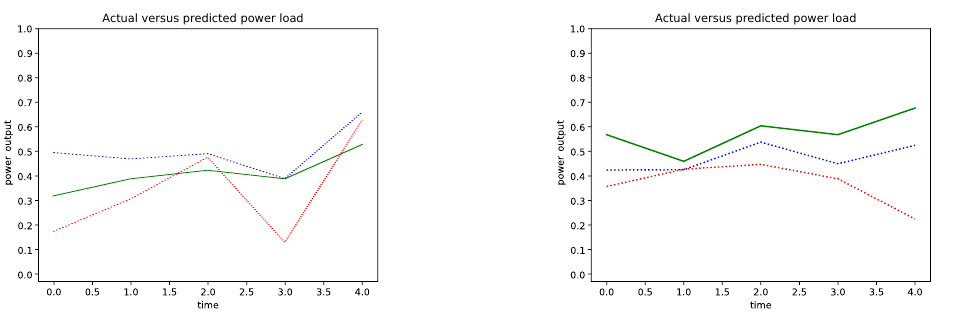
Figure 6. Two sample output of the power load predictions. The blue plot line shows the predicted power load by the ANN that used the LSTM’s outputs of the predicted weather conditions, the red plot line is the ANN’s power load prediction using the measured weather conditions, and the green solid plot line is the actual measured power load. Each major unit on the x-axis is a prediction of 10 min into the future from the start